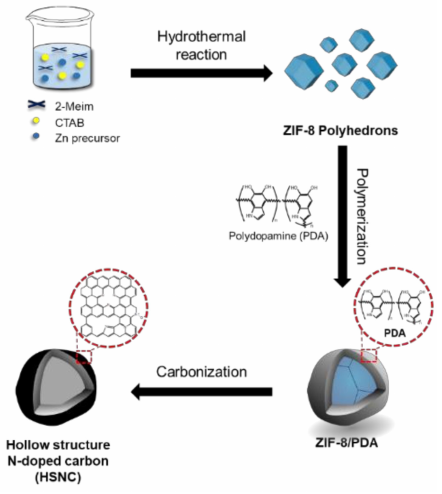
Figure 1. Preparation of the